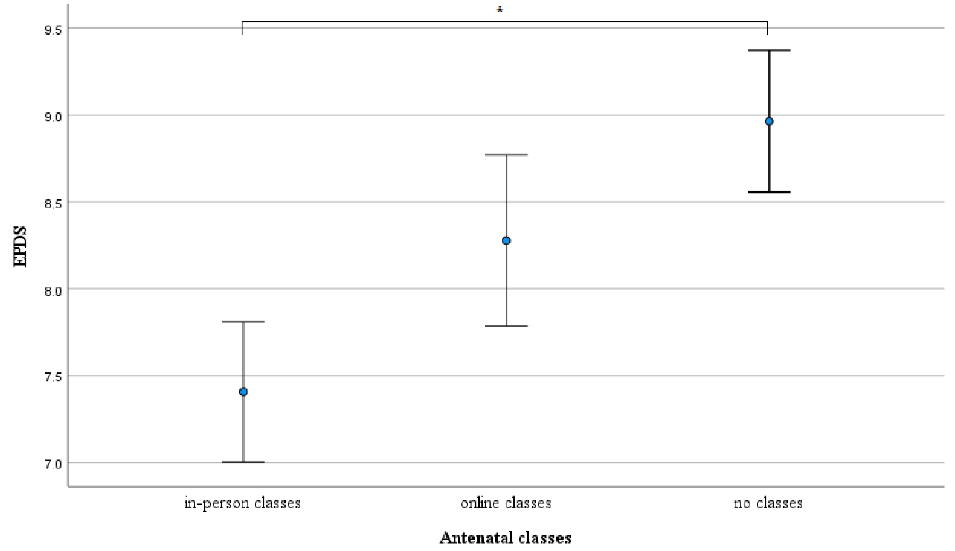
Figure 2. Differences in mean levels of depression (dots) between in-person antenatal classes participants, online antenatal classes participants, and non-participants of any kind of antenatal classes adjusted for maternal age, pregnancy complications, and COVID infections. Whiskers show 95% CI, * p < 0.05.